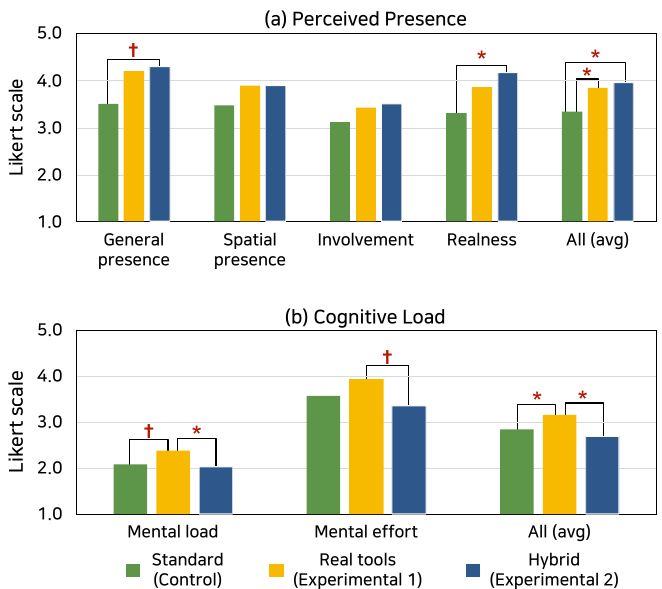
Figure 7. User study results: ( a ) perceived presence and ( b ) cognitive load comparisons across control (two standard VR controllers) condition, experimental #1 (four real tools) condition, and experimental #2 (hybrid with one real tool and one standard VR controller) condition ( † p < 0.10; ∗ p <